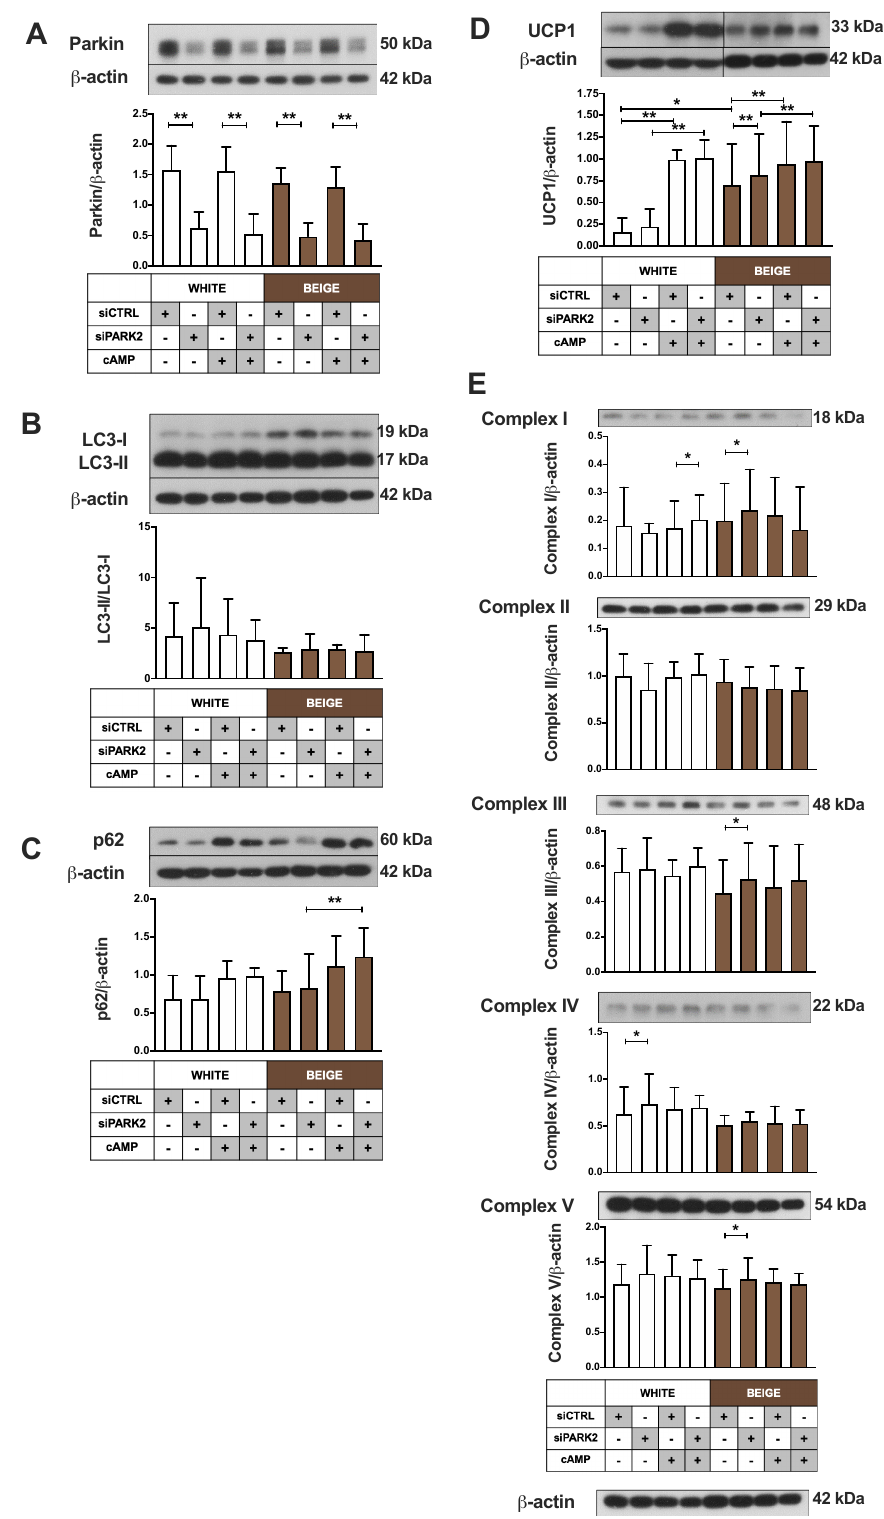
Figure 6. The impact of Parkin silencing on autophagy and the expression of UCP1 and mitochondrial complexsubunits. Representativeimmunoblotsanddensitometryanalysisof( A )Parkin, ( B )LC3-II / LC3-I ratio, ( C ) p62, ( D ) UCP1 and ( E ) mitochondrial complex subunits protein expression in PARK2-silenced hASCs under untreated conditions or after cAMP-stimuli (500 µ M, 10 h), normalized to β -actin ( n = 4). Results are expressed as mean ± SD. Statistics: two-tailed paired student t -test; * p < 0.05; ** p <